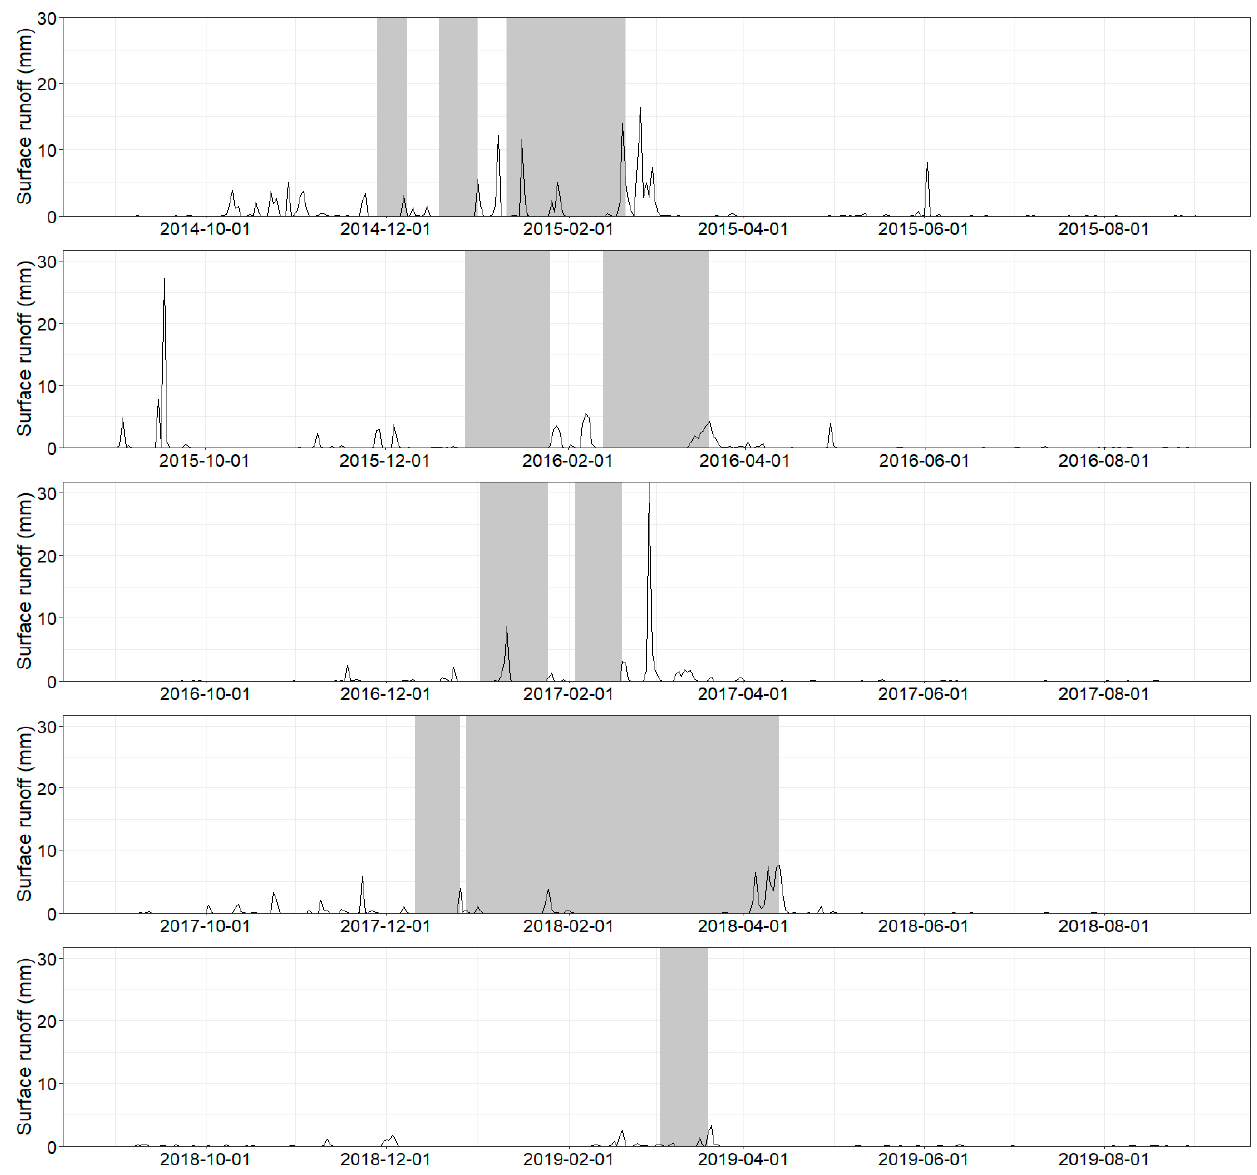
Figure 1. Timeseries for average surface runoff and periods with snowcover marked in gray.